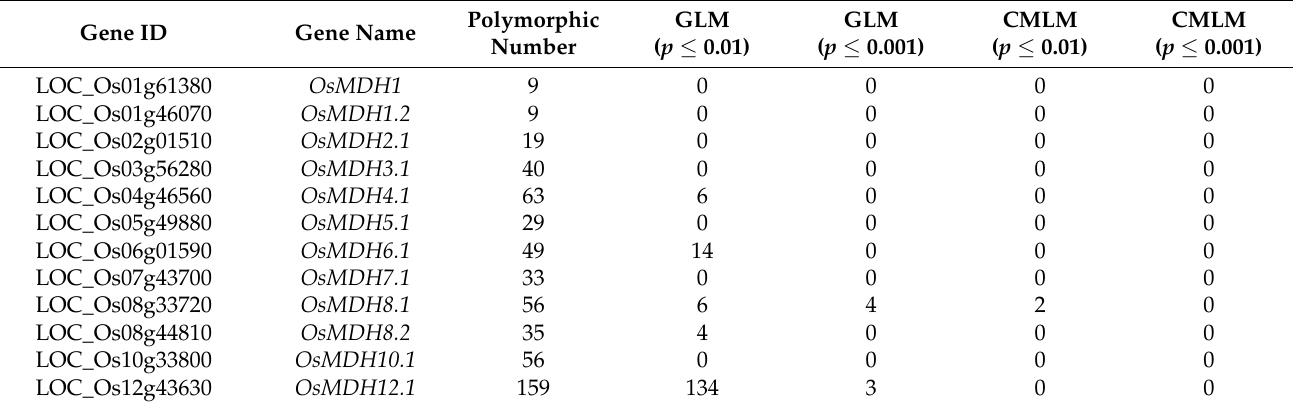
Table 2. Association analysis of natural variation in OsMDH genes with salt tolerance at the seedling stage in the rice diversity